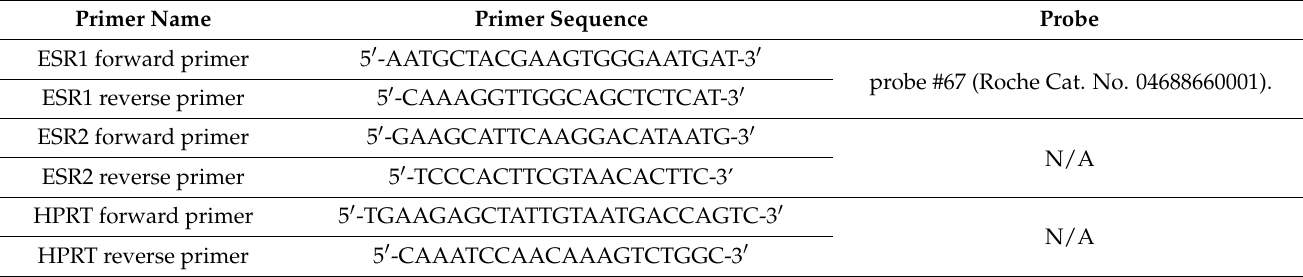
Table 2. Primers and probes used in qPCR.